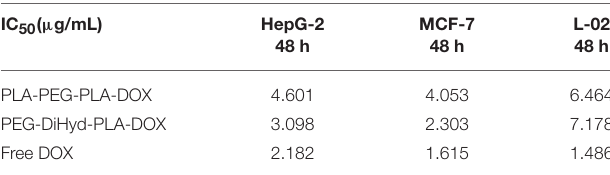
TABLE 2 | Half-inhibitory concentration (IC 50 ) of loaded-DOX micelles and free DOX on HepG-2, MCF-7, and L-02 cells. IC 50 ( µ